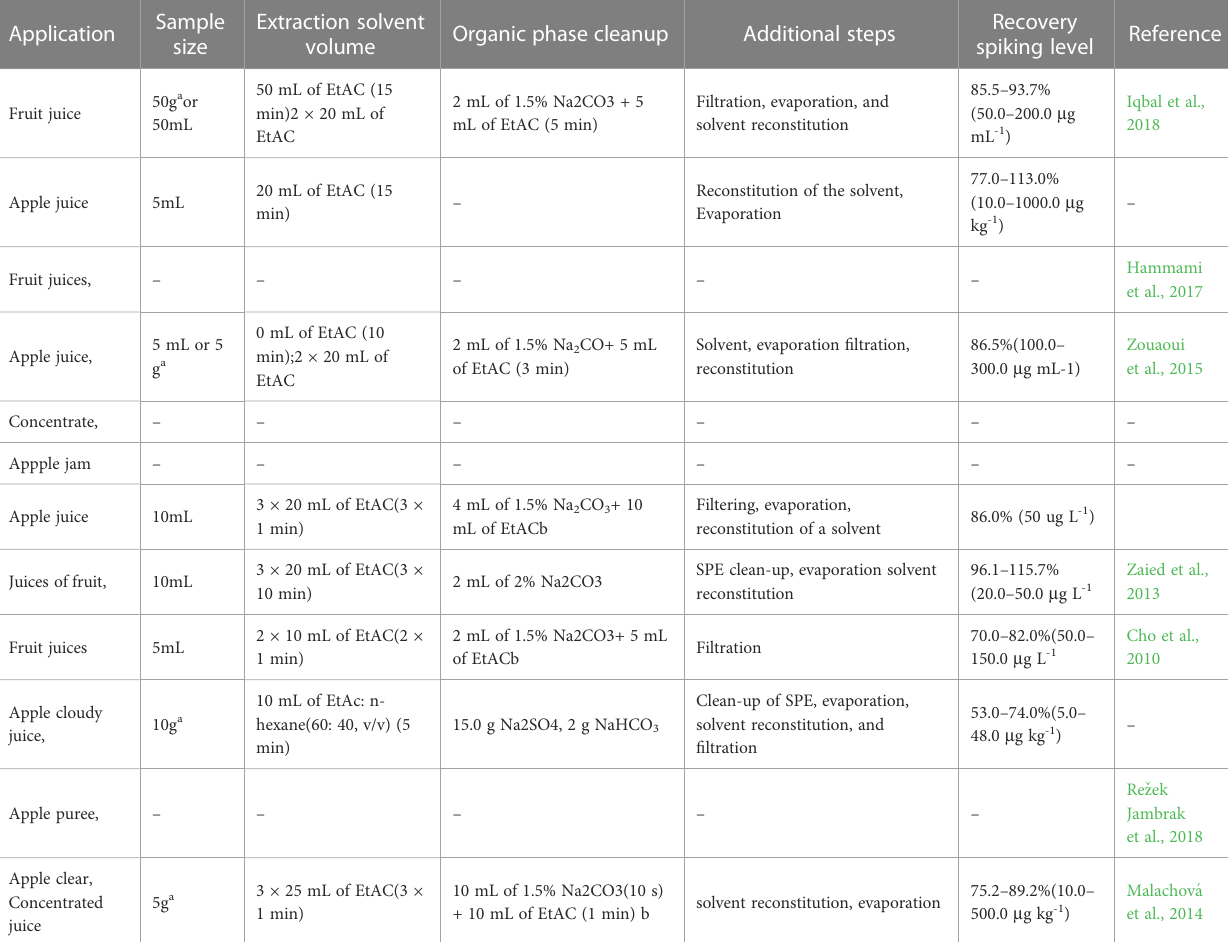
TABLE 3 Comparison of Liquid liquid extraction conditions used for fruit commodity preparation for patulin